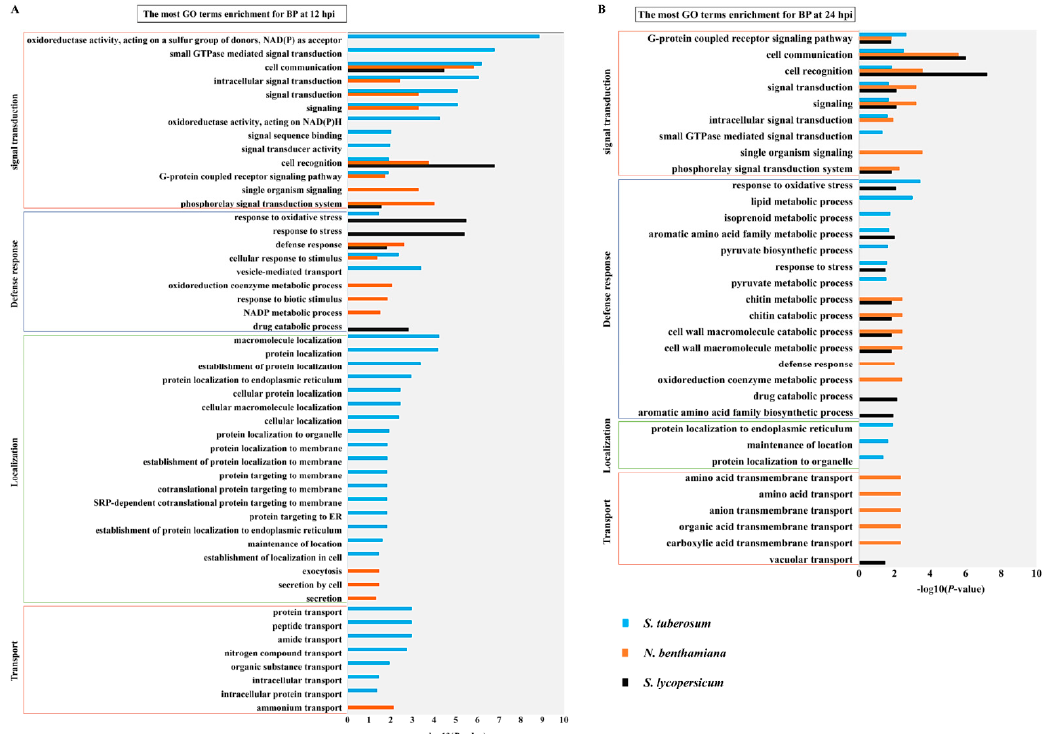
Figure 4. Analysis of biological process in TSHs related response induced by P. infestans . ( A ) GO annotation of identified response-related genes in biological processes (BPs) for TSHs at12 hpi; BP terms comparation among TSHs are represented by histogram. The horizontal axis was derived from their log10 ( p -value) (adjusted p -value < 0.05), vertical axis represented GO terms. ( B ) GO annotation of identified response-related genes in biological processes (BPs) for TSHs at 24 hpi. Within each host analysis, the blue bar represented potato, the orange bar represented N. benthamiana and the black bar represented tomato.